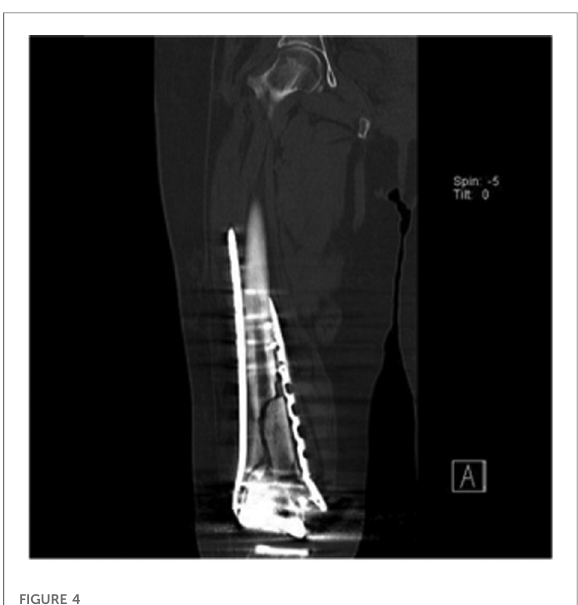
FIGURE 4 Coronal CT image of the right femur one year after